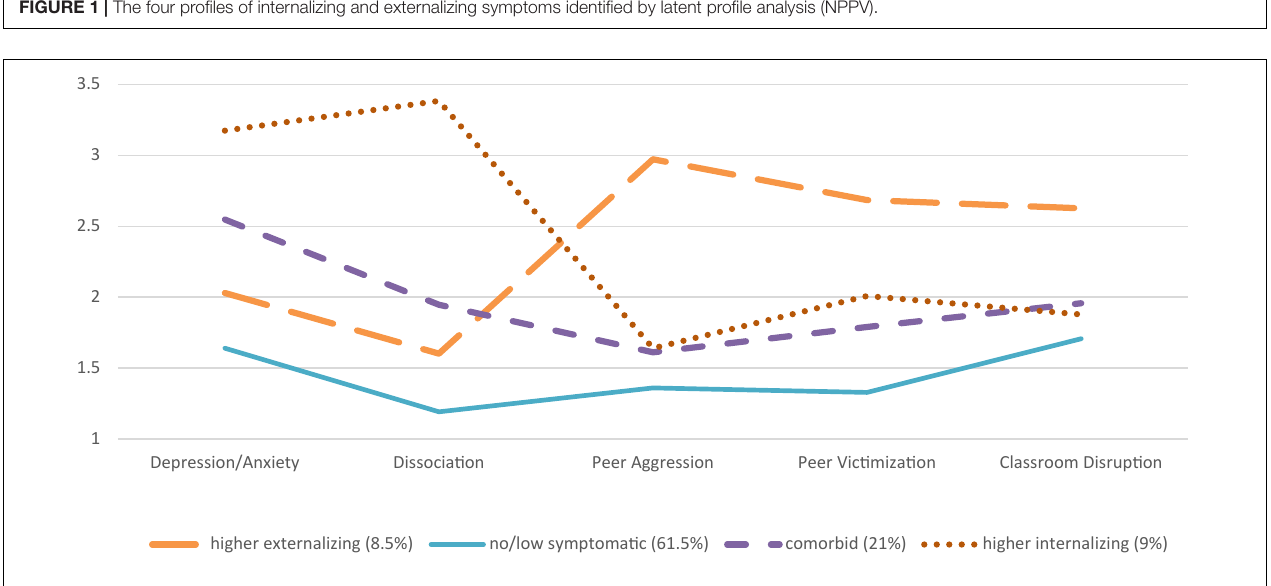
FIGURE 2 | The four profiles of internalizing and externalizing symptoms identified by latent profile analysis